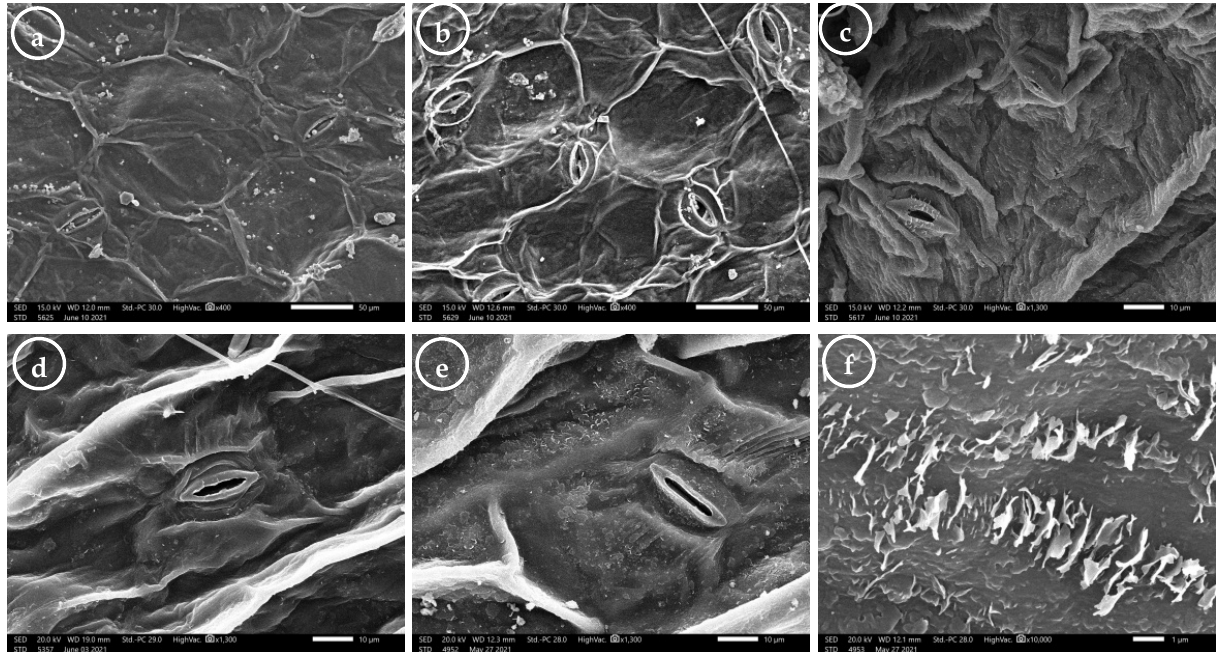
Figure 4. Scanning electron microscope (SEM) photomicrographs of Trianthema portulacastrum leaf surfaces: ( a , b ) general view showing the epidermal cell outline, anticlinal wall, curvature of the outer periclinal wall, and fine relief of the cell wall; ( c – e ) showing the fine relief of the cell wall, guard cell surface, pore shape, and epicuticular secretion type; ( f ) irregular thin platelets with an irregular margin. Abaxial leaf surface ( b – d ); Adaxial leaf surface ( a , e , f ). Scale bar= 50 µm ( a,b ); 10 µm ( c,d,e ); 1 µm ( f ).